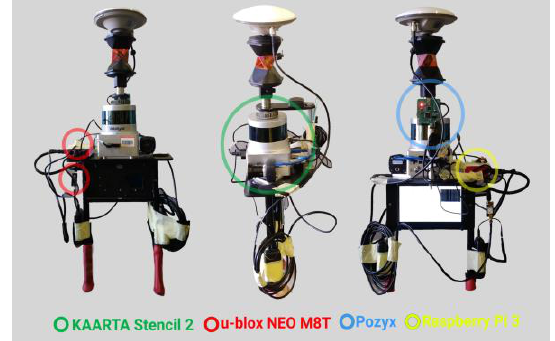
Figure 1. The multi-sensor platform which integrates: the KAARTA Stencil 2-16 MMS, two u-blox NEO M8T GNSS receivers, the Pozyx UWB and the Raspberry Pi 3 Model b+.